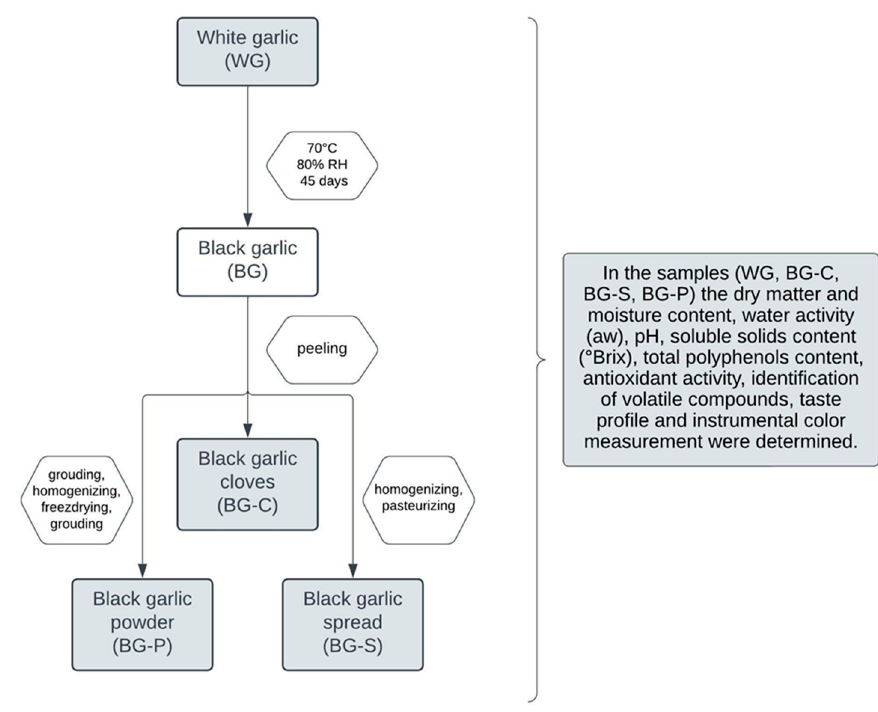
Figure 1. The flow diagram showing the methodology followed in the study. The black garlic was peeled, the cloves were separated, and all material obtained in this way was divided into three parts (BG-C, BG-P, BG-S). Garlic in the form of cloves (BG-C) was stored in a glass vessel under refrigeration conditions (10 °C and 85% relative air humidity) until physicochemical tests were carried out. To prepare the black garlic powder (BG-P), the cloves were ground, homogenized for 1 min (10,000 rpm), (IKA T18 Basic ULTRA-TURRAX ® , IKA ® Poland Ltd., Warsaw, Poland), placed in in plastic con- tainers, frozen in liquid nitrogen and freeze-dried (Alpha 1-4 LSC, Martin Christ GmbH, Osterodeam Harz, Germany) at a chamber pressure of 10 Pa, a drying chamber tempera- ture of − 50 °C and a shelf of 21 °C for 72 h. The freeze-dried black garlic macerate was